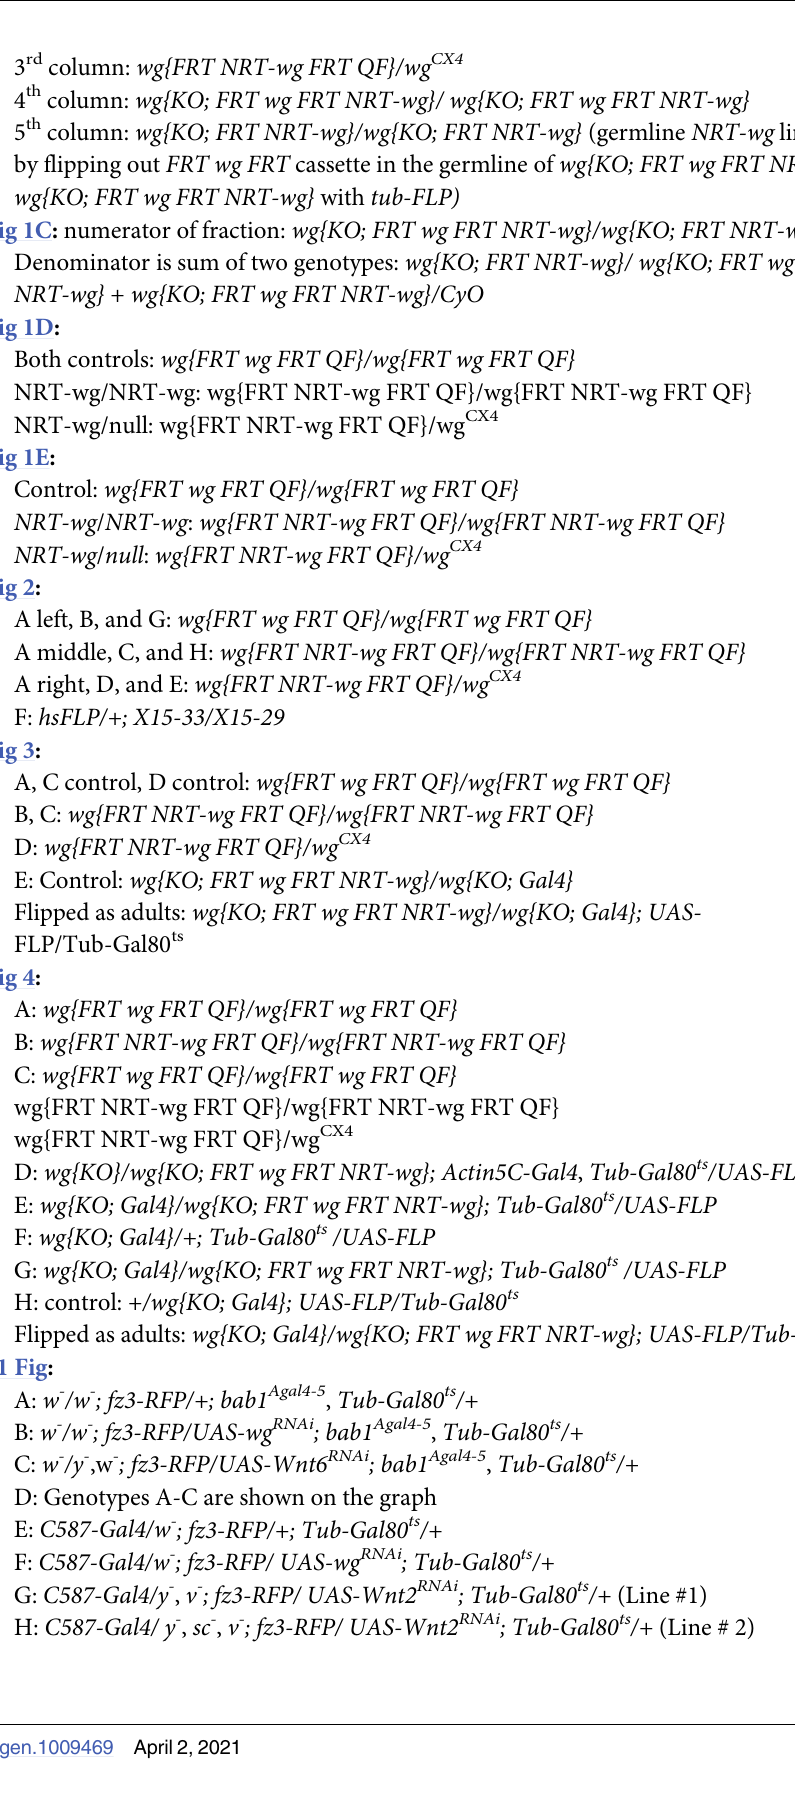
Fig 1C: numerator of fraction: wg{KO; FRT wg FRT NRT-wg}/wg{KO; FRT NRT-wg} Denominator is sum of two genotypes: wg{KO; FRT NRT-wg}/ wg{KO; FRT wg FRT NRT-wg} + wg{KO; FRT wg FRT NRT-wg}/CyO Fig 1D: